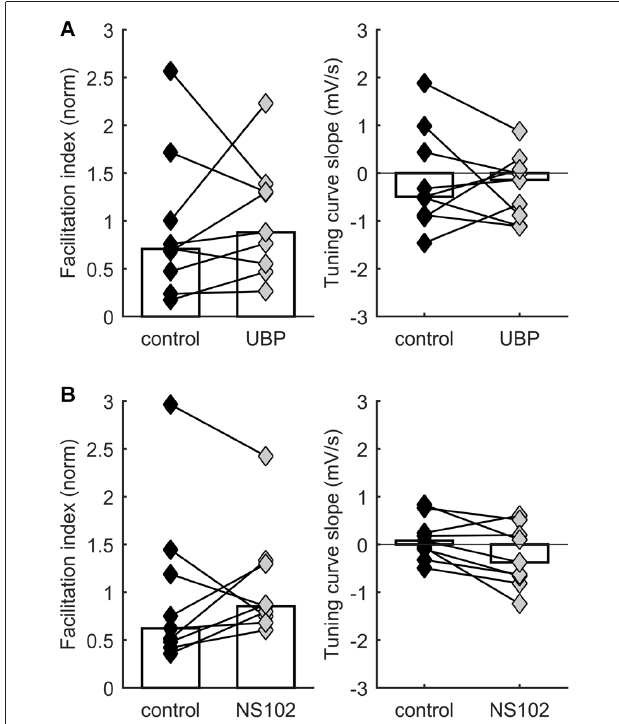
FIGURE 3 | STP distribution is not consistently affected by kainate receptor activation . Each connected pair of points is one recording. Bars represent population median. (A) No significant effect on facilitation index (left) or on TCS (right) of application of UBP 310, a specific blocker of GluK1-containing receptors. (B) No significant effect on facilitation index (left) or on TCS (right) of application of NS-102, a specific blocker of GluK2-containing